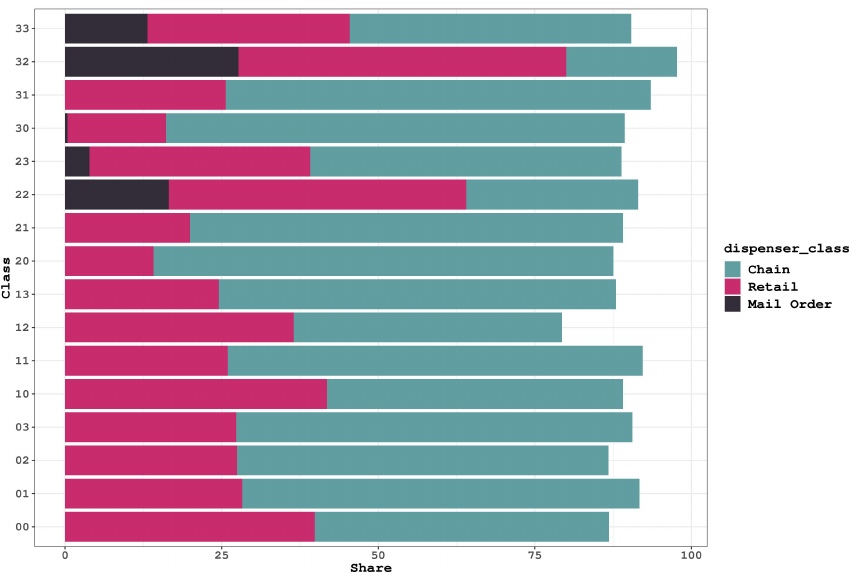
Figure 4. Pharmacy Distribution by Class: Chain and Retail Pharmacies Dominate, While Mail-Order Pharmacies Appear in Problematic Classes.